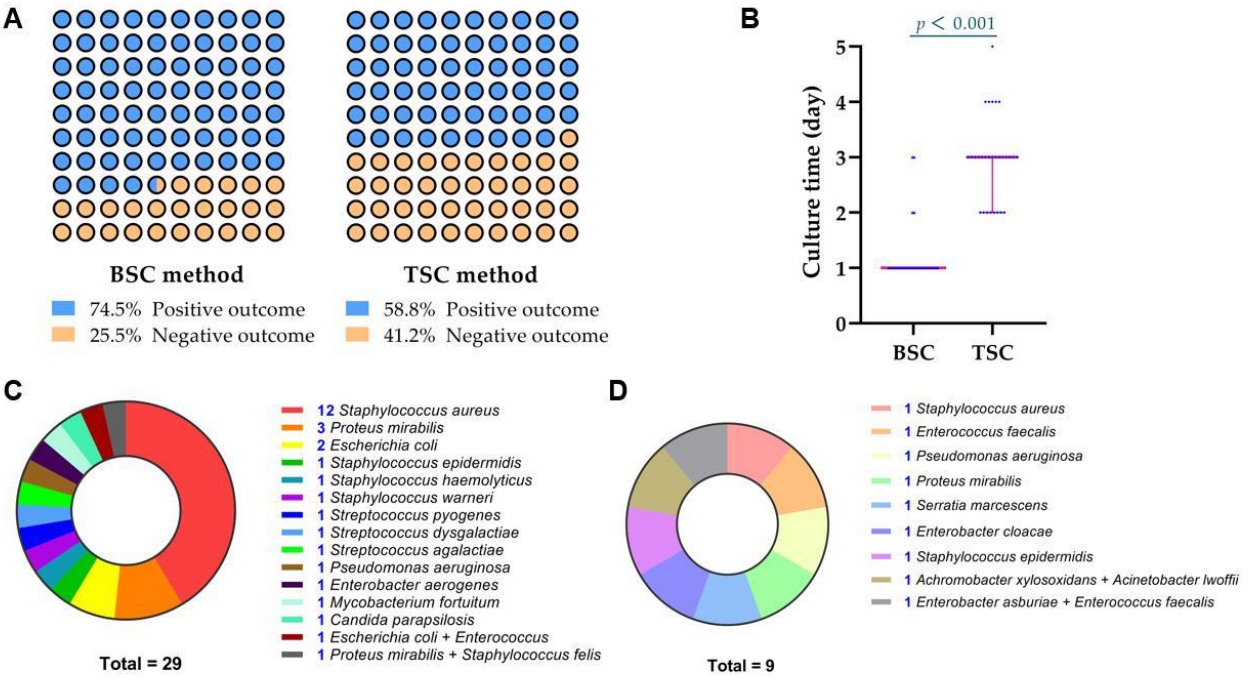
Figure 3. Graphical representation of the primary outcomes of the current study. Panel ( A ): Positive rates of the BSC and TSC strategies. Panel ( B ): The culture time of the BSC group was shorter than TSC group (a Wilcoxon signed-rank test, p < 0.001). Panel ( C ): Distribution of the microorganisms detected by both BSC and TSC, with consistent results. Panel ( D ): Distribution of the microorganisms identified by only BSC while TSC showed negative outcomes.